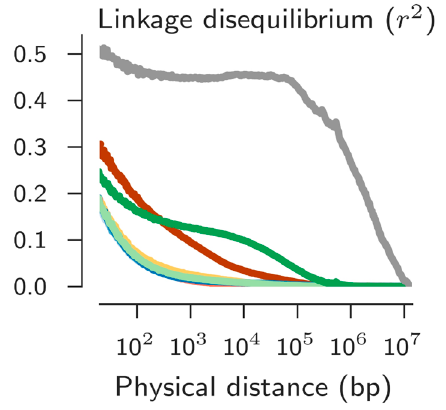
Figure 5. Linkage disequilibrium across populations of An. coluzzii and An. gambiae s.s. Four indistinguishable lines with lowest LD are from West Africa. Maroon line is A. coluzzii from Angola, dark green line is An. gambiae s.s. from Gabon, and the grey is An. gambiae s.s. from Kenya. From Reference [11].